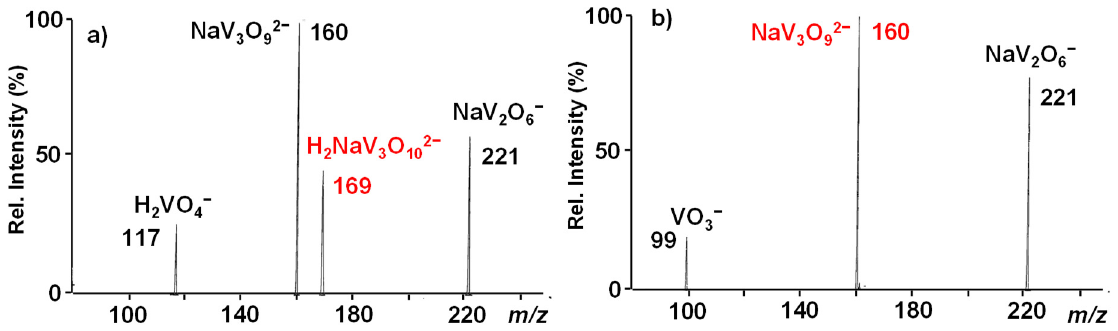
Figure 2. IT CID mass spectra of ( a ) the H2NaV3O102 − reactant ion at m / z 169 and ( b ) the NaV3O9 2 − daughter ion at m / z 160 isolated from the MS3 sequence 169 → 160.